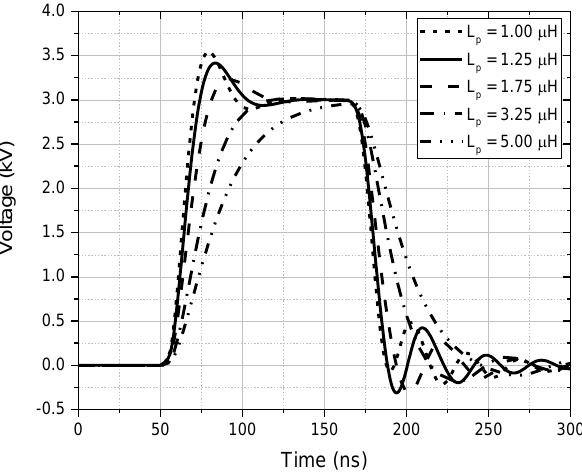
Ω without the snubber and crowbar